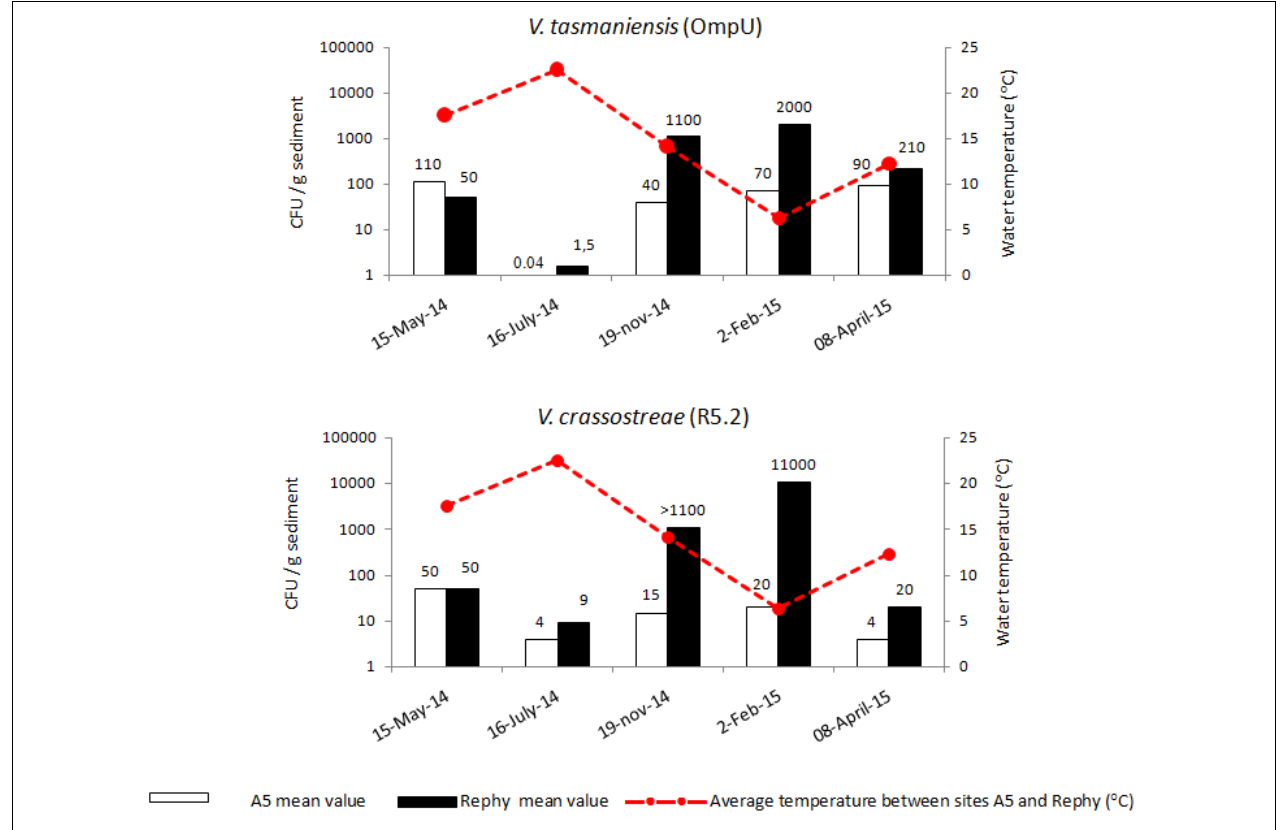
FIGURE 6 | Seasonal abundance of vibrios in the sediment. Mean concentration of Vibrio tasmaniensis and Vibrio crassostreae (MPN CFU/g) in the surface sediment collected outside the oyster culture area (A5, white bar ) and inside an oyster farm (Rephy, black bars ). Mean subsurface seawater temperature ( ◦ C) is represented by a red